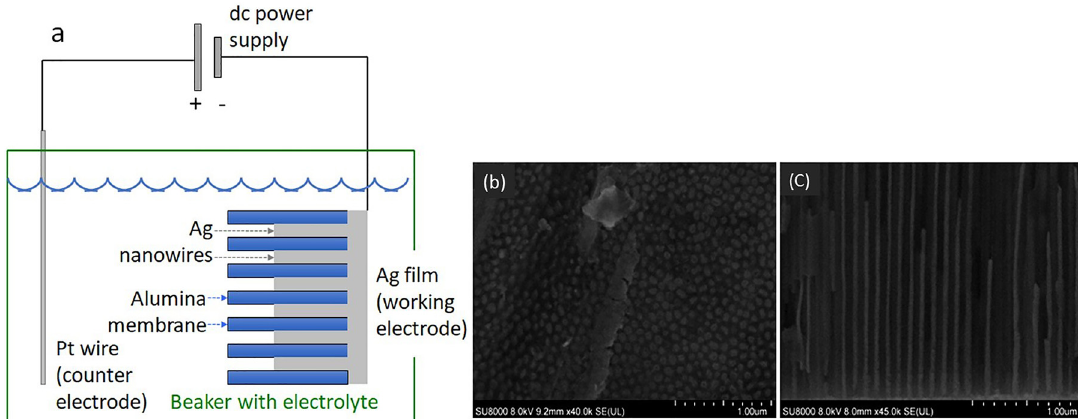
Figure 1: Experimental samples (a) Schematic of the electrodeposition setup. Surface (b) and cross-sectional (c) images of the alumina membrane with grown silver nanowires, obtained using fi eld emission scanning electron microscope (FESEM SU8010 from Hitachi). In the process of electrodeposition, the surface imaged in (b), and the upper ends of the wires depicted in (c) were facing the